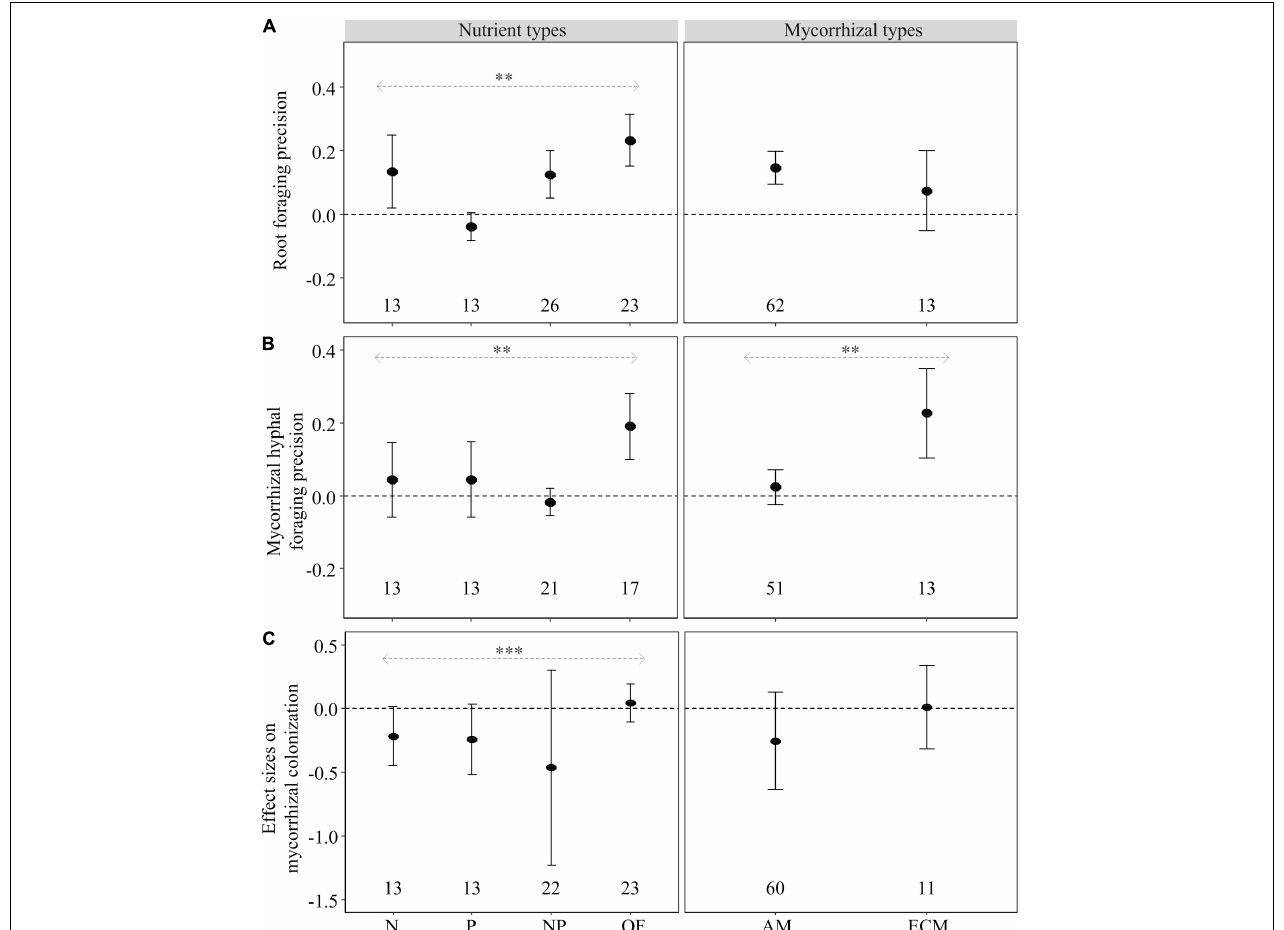
FIGURE 3 | Mean effect sizes (closed circles) of the heterogeneous nutrient supply effects on root proliferation (root foraging precision) (A) , mycorrhizal hyphal length or hyphal biomass (mycorrhizal hyphal foraging precision) (B) and mycorrhizal colonization (C) of woody species as influenced by nutrient types (N, P, NP, or OF = organic fertilizer or organic matter) and mycorrhizal types (AM and ECM) based on the second dataset. Error bars (when larger than the symbol) represent ± 95% confidence intervals. Effects are significant if confidence intervals (95% CI) for a given parameter do not overlap with zero. Mean effect sizes < 0 represent a reduction (and > 0 an increase) in plant growth in nutritionally heterogeneous patches compared with unfertilized control. The numbers under the CI bars represent the sample sizes. The asterisks denote significant difference among the categories. ∗∗ P < 0.01; ∗∗∗ P <